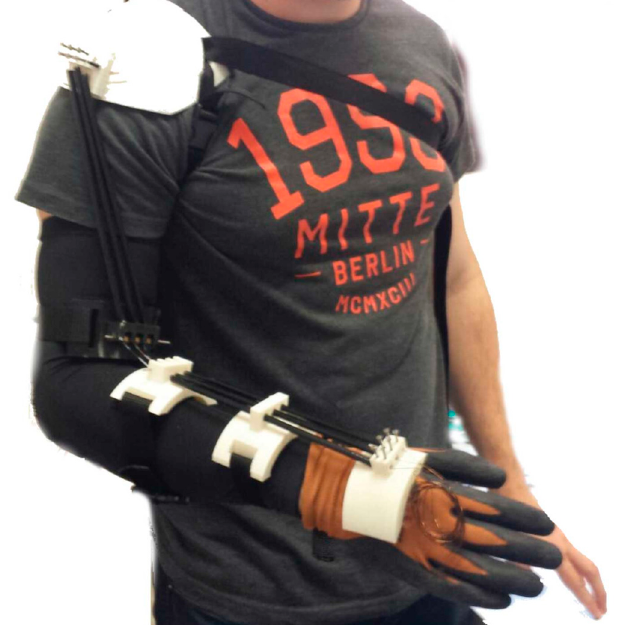
Figure 6. Illustration of a SMA ‐ driven soft wearable. Copaci et al. [142] describe their work on a SMA ‐ driven rehabilitative elbow wearable. SMA wires serve the same function as cables, providing a contractile force for joint motion. In their work, the process of heating the SMA wire takes 4.5 s while the cooling phase takes 25 s.